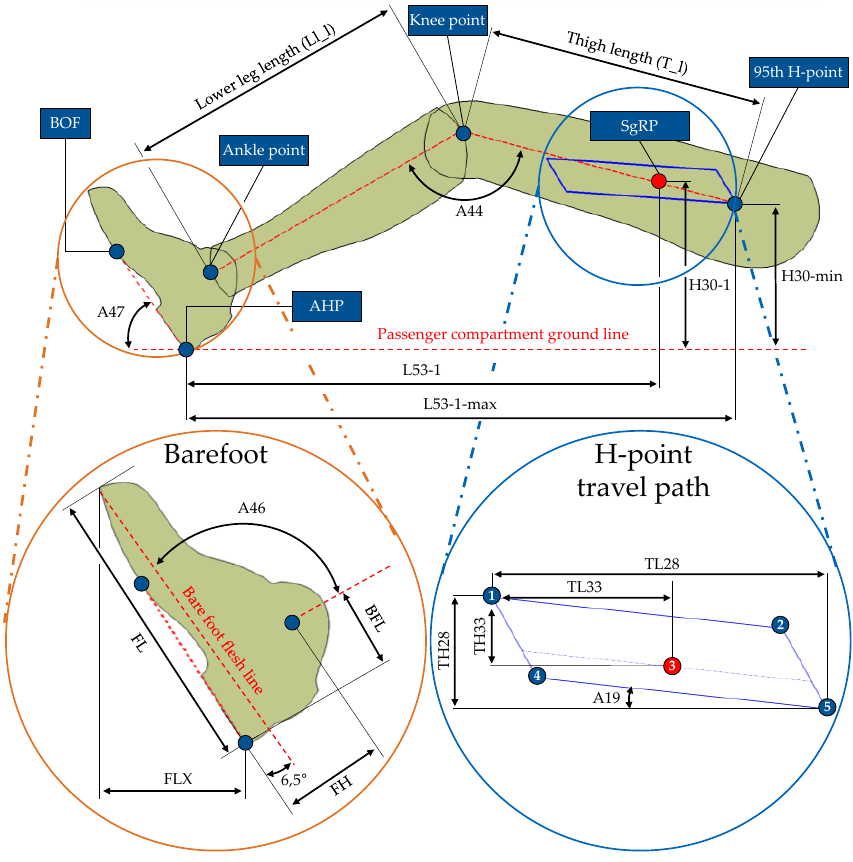
Figure 3. Main dimensions and angles for the description of the driver’s legroom.